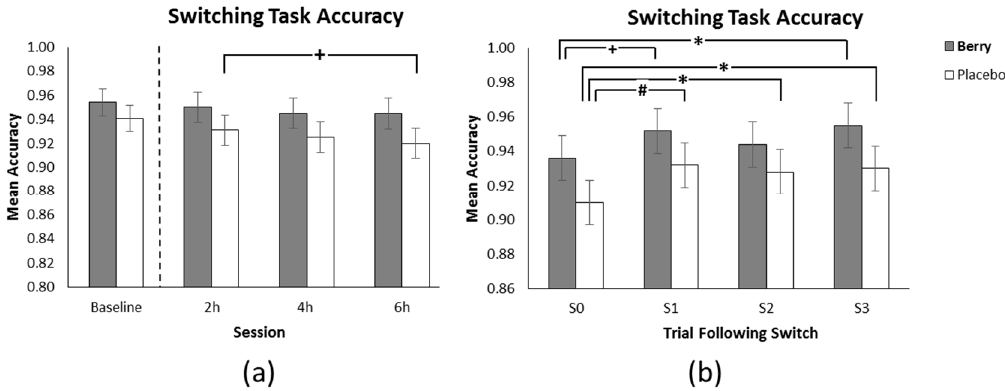
Figure 5. ( a ) Mean correct responses ( ± SE of the mean) as a function of intervention and session. ( b ) Mean correct responses ( ± SE of the mean) as a function of intervention and switch trial showing a significant switch cost between S0 and S1, S2, and S3 for placebo and a significant switch cost only between S0 and S3 for berry. Baseline performance, included as a covariate in the analysis, is shown on graph A separated by the dotted line. + p < 0.1, * p < 0.05, # p < 0.01.